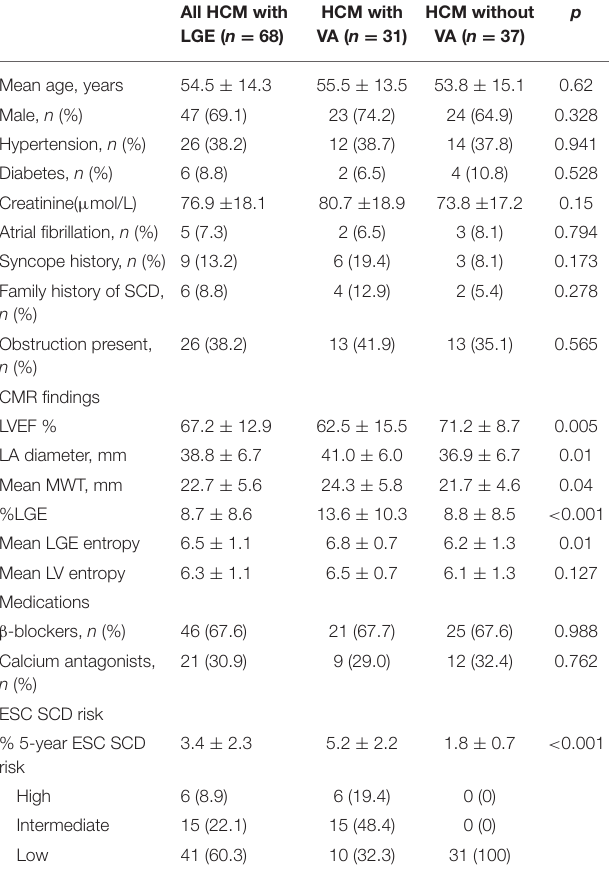
TABLE 1 | Clinical characteristics in HCM patients with or without ventricular arrhythmias. All HCM with LGE ( n =